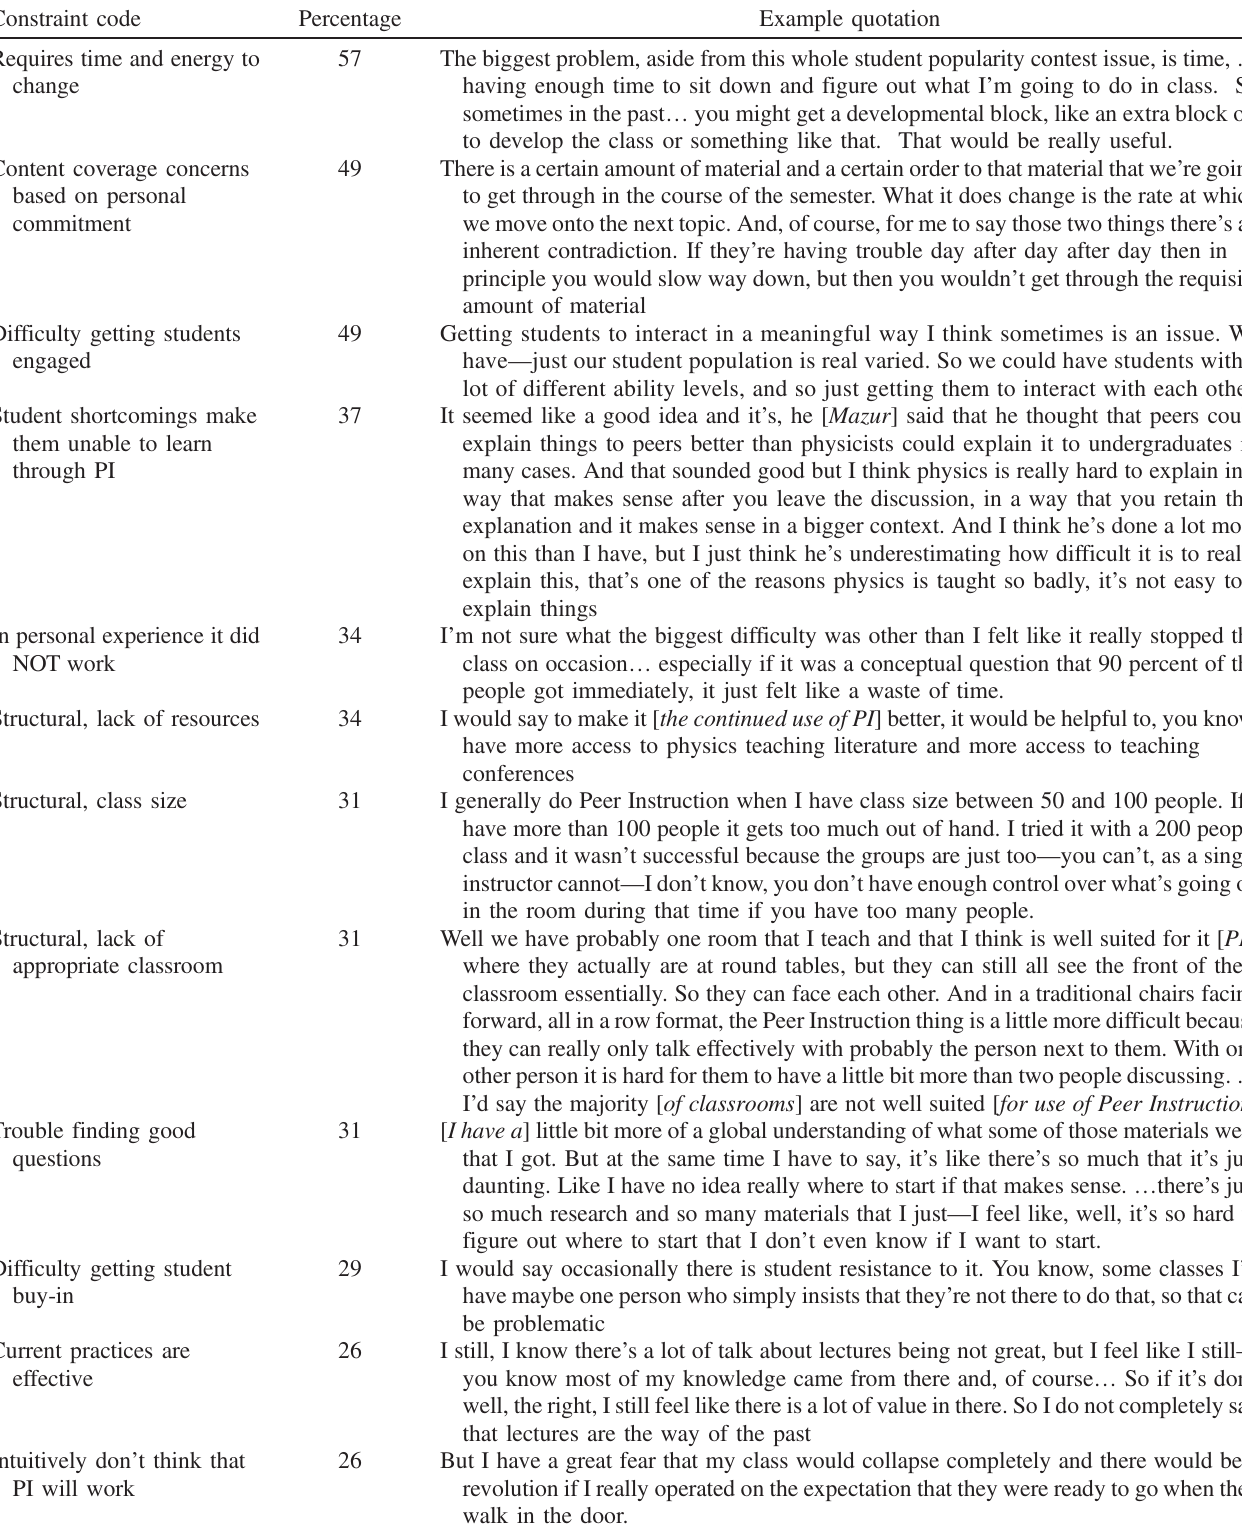
TABLE II. Constraints of Peer Instruction. Rank-ordered list of reasons given for NOT aligning instructional practices with PI (or PI